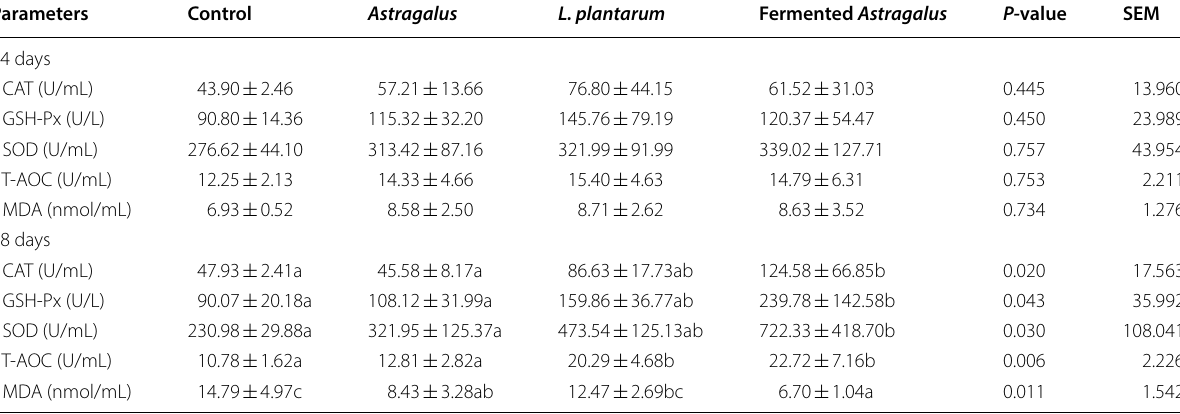
Table 5 Effects of different dietary supplements on the antioxidant status of laying hens Parameters